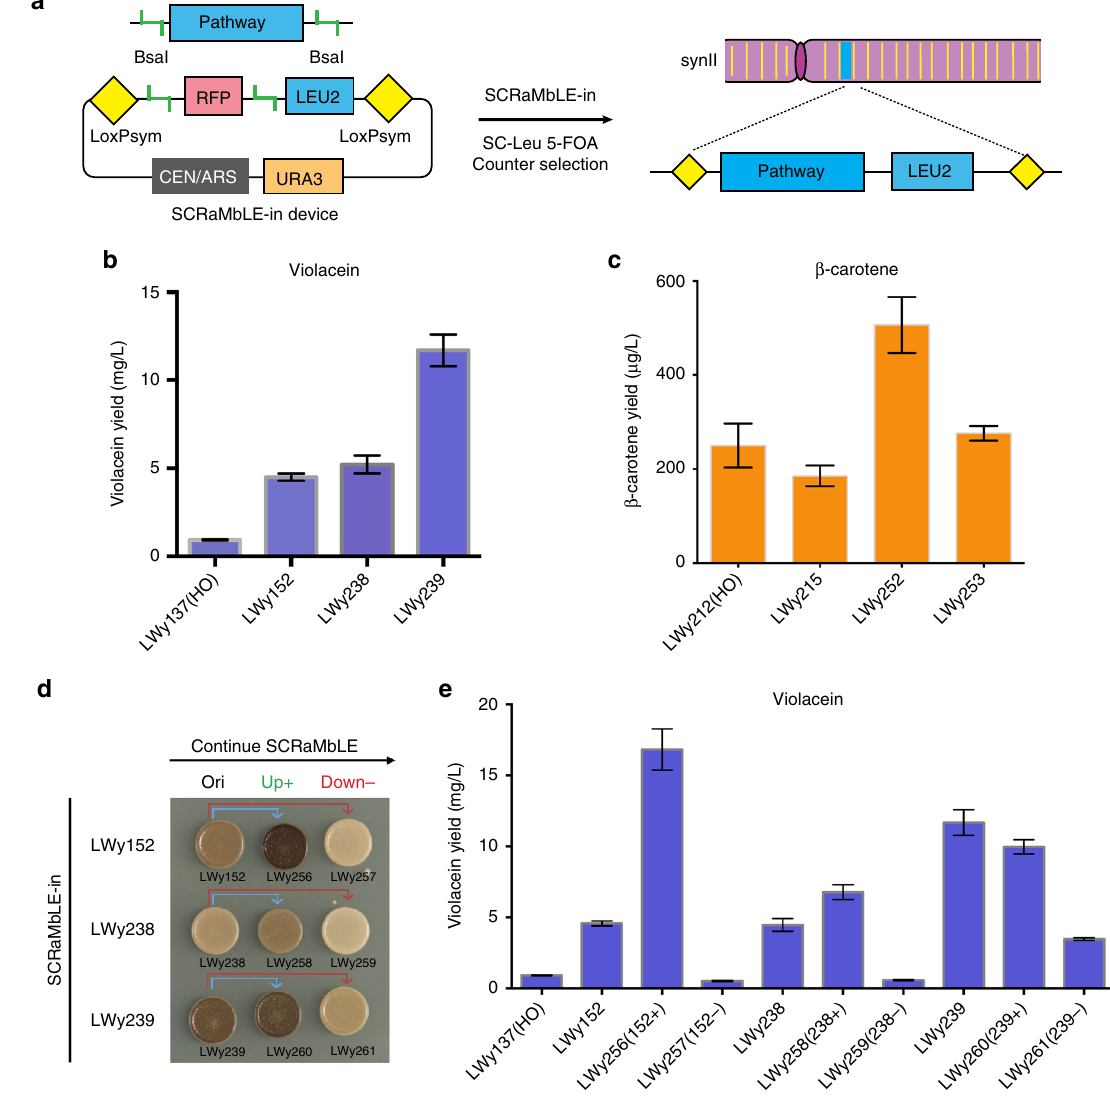
Fig. 4 Induction and screening of pathway SCRaMbLE-in yeast variants. a A URA3 -based counter selection strategy to facilitate the SCRaMbLE-in process. The SCRaMbLE-in device is based on a yeast centromeric plasmid with URA3 marker (pRS416). A BsaI site- fl anked RFP cassette and a LEU2 expression cassette were placed between two loxPsym sites. LEU2 is used as positive selection marker for integration and URA3 is used as counter selection marker for non-integrated strains. After SCRaMbLE-in induction, successful integrated colonies were selected on SC-Leu + 5-FOA plates. b Violacein quanti fi cation in the violacein pathway SCRaMbLE-in variants. LWy137 is control strain with a single-copy violacein pathway inserted at the HO locus. LWy152, LWy238, and LWy239 are violacein SCRaMbLE-in strains. Error bar represents the standard deviation, n = 3. c β -carotene quanti fi cation in β - carotene pathway SCRaMbLE-in variants. LWy212 is control strain with a single-copy β -carotene pathway inserted at the HO locus. LWy215, LWy252, and LWy253 are β -carotene SCRaMbLE-in strains. Error bar represents the standard deviation, n = 3. d Color comparison of continuous SCRaMbLEd variants with violacein integrated pathway. Both darker colony color and lighter colony color were observed for the three SCRaMbLE-in strains with continuous SCRaMbLE. LWy152, LWy238, and LWy239 are SCRaMbLE-in strains; LWy256 and LWy257 are continuous SCRaMbLEd strains from LWy152; LWy258 and LWy259 are continuous SCRaMbLEd strains from LWy238; LWy260 and LWy261 are continuous SCRaMbLEd strains from LWy239. e Violacein quanti fi cation of continuous SCRaMbLEd variants with violacein integrated pathway. 152 + : increased production compared with source strain LWy152; 152 − : decreased production compared with source strain LWy152. Error bar represents the standard deviation, n =